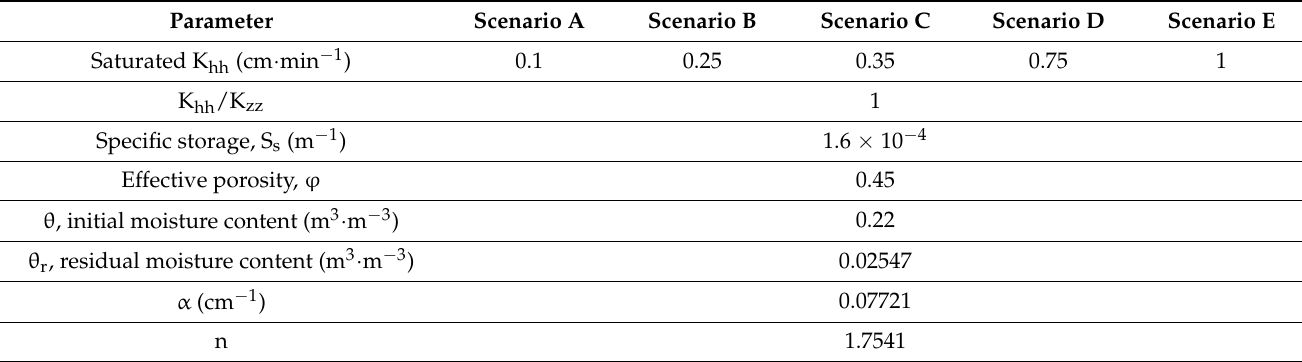
Table 2. Parametrization of the model